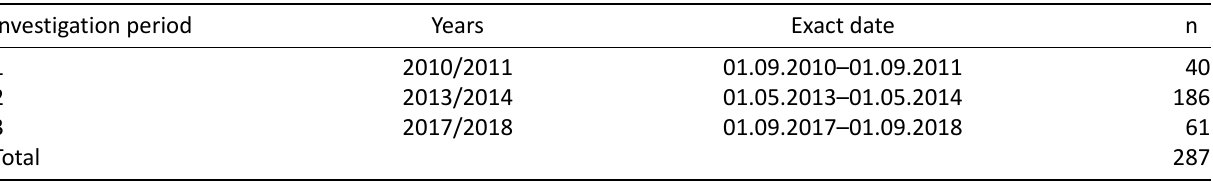
Table 1. Investigation